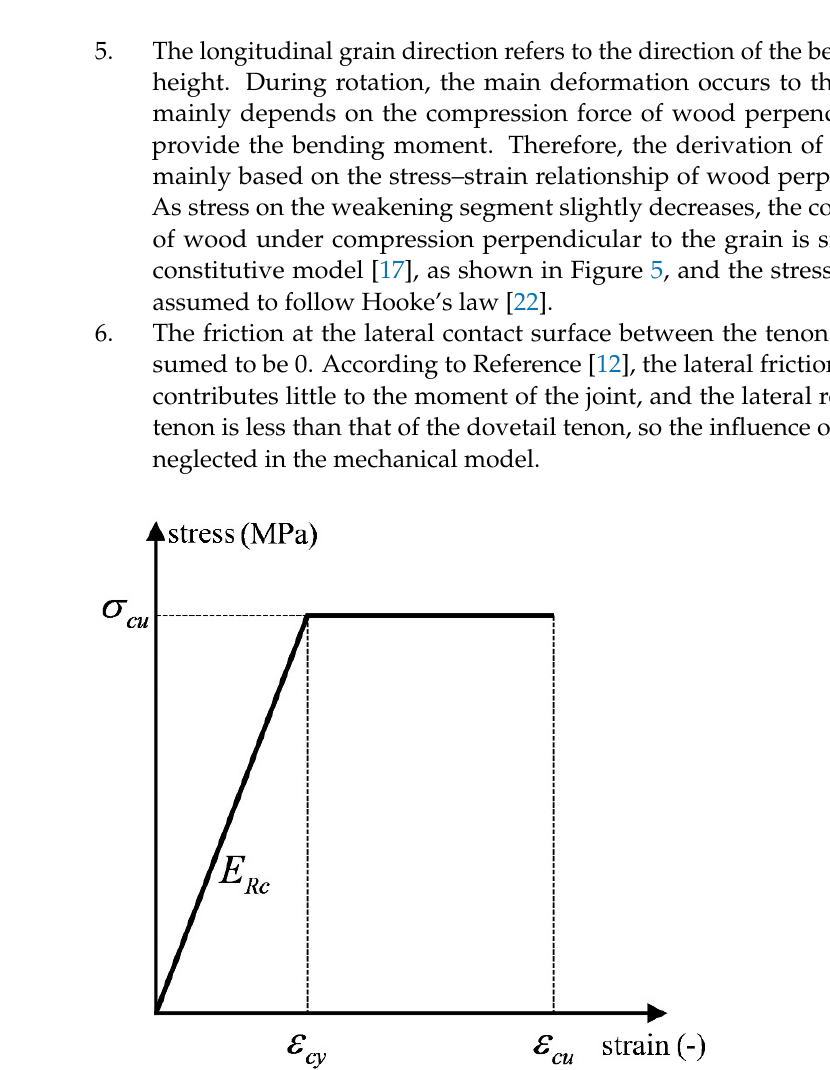
Figure 5. Double-linear constitutive model of wood perpendicular to the grain under compression. Note: σ cu and ε cy are the peak compressive stress and strain respectively; ε cu is the ultimate compressive strain; E Rc is the elastic modulus.